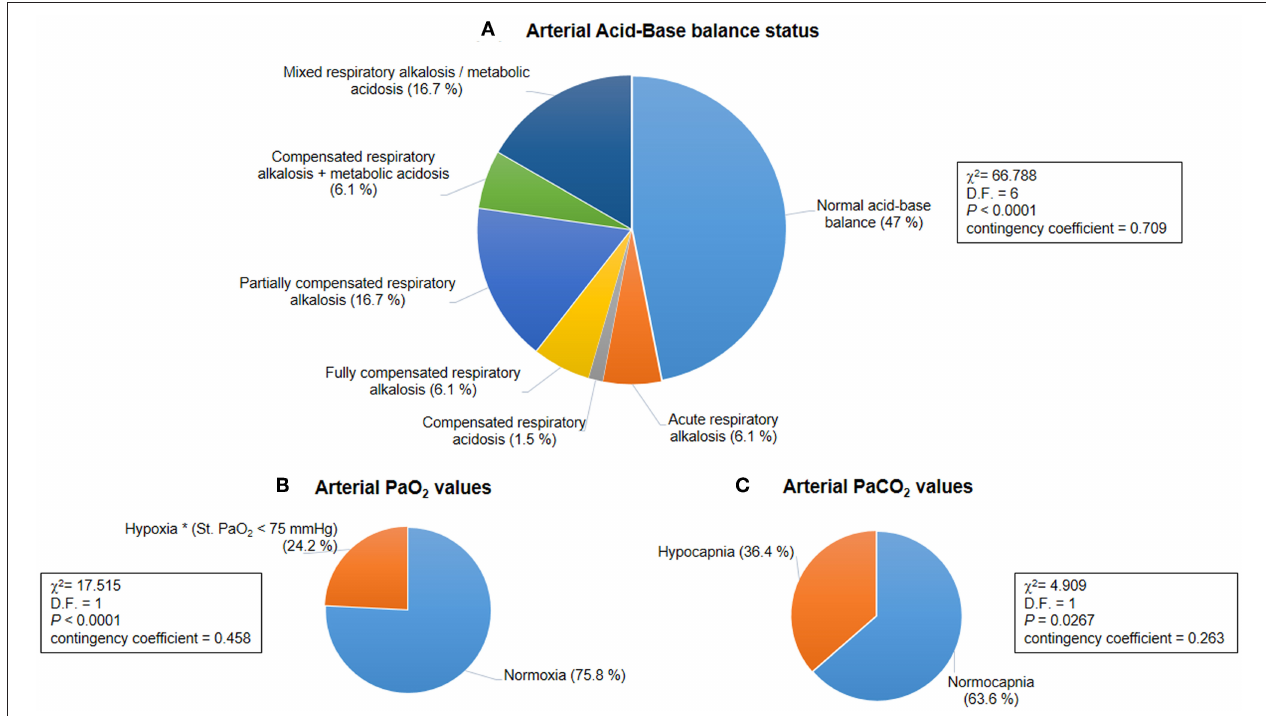
FIGURE 1 | Baseline acid-base balance and gas analysis status for the whole population with Rett syndrome (RTT) ( n = 66). (A) Distribution of patterns of the arterial acid-base balance status was significantly different ( p < 0.0001). (B) A hypoxic condition (i.e., arterial blood Std. PaO 2 < 75 mmHg) was observed in 24.2% of the whole population with RTT ( p < 0.0001). (C) Hypocapnia (i.e., arterial blood PaCO 2 < 35 mmHg) was present in 36.4% of all the examined patients with RTT ( p = 0.0267). PaO 2 , partial arterial pressure of oxygen; PaCO 2 , partial arterial pressure of carbon